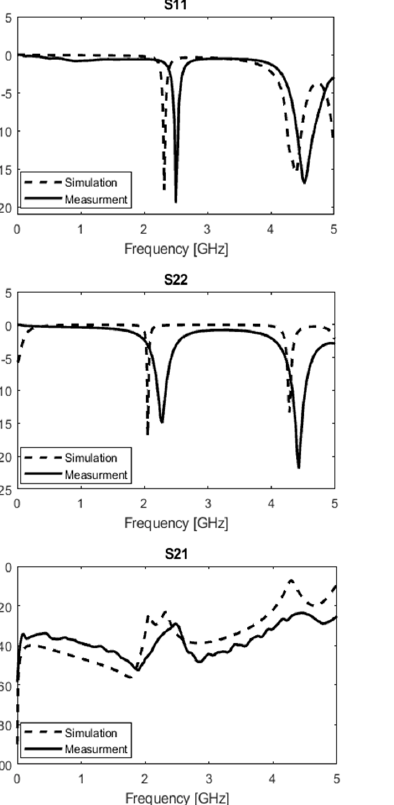
Figure 3. Proposed antennas ( a ) wearable antenna on hand, ( b ) antenna structure, ( c ) flexible antenna on phantom body model, and ( d ) experimental setup. Sensors 2019 , 19 , x FOR PEER REVIEW Table 2. Resonance frequencies (GHz) (M: Measurement, S: Simulation).